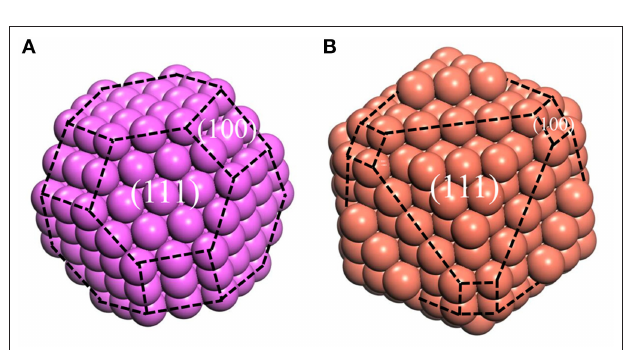
FIGURE 4 | the model of atomic clusters, (A) Aluminum at 1,250 ◦ C, (B) Copper at 1,350 ◦ C. The purple and red balls represent the Al and Cu atoms, respectively. The black dotted lines represent the boundary of different